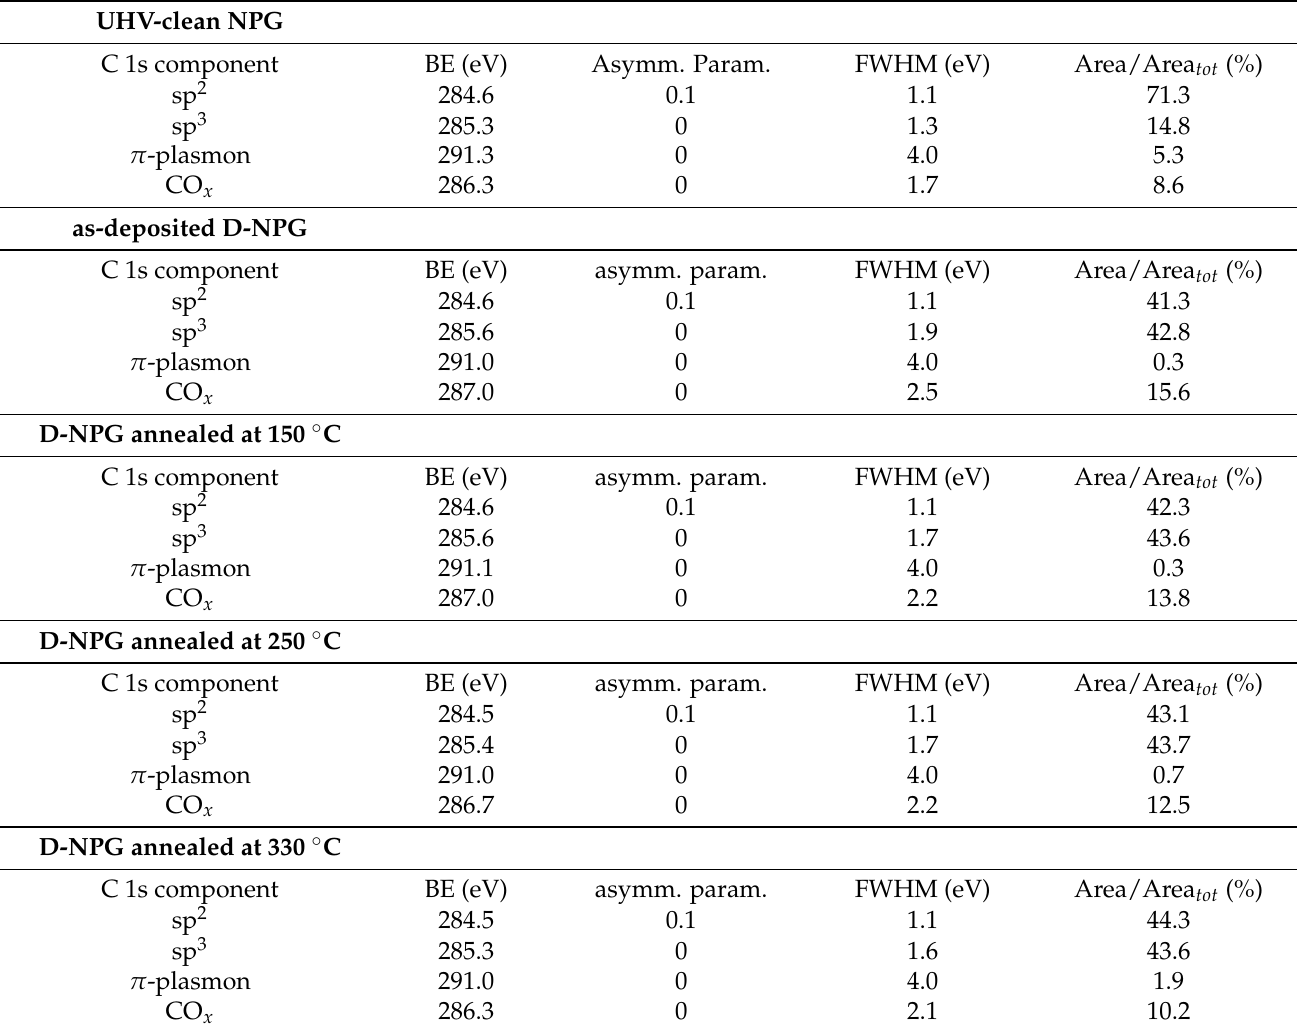
Table 1. Fit values for the C 1s core level of UHV-clean NPG, as-deposited D-NPG and D-NPG after annealing at 150, 250 and 330 ◦ C. Component, binding energy ( ± 0.1 eV, ± 0.3 eV for the π -plasmon), asymmetry parameter, full-width at half-maximum (FWHM, ± 0.1 eV), relative intensity (peak areas in %, ± 5%). UHV-clean NPG C 1s component BE (eV) Asymm.